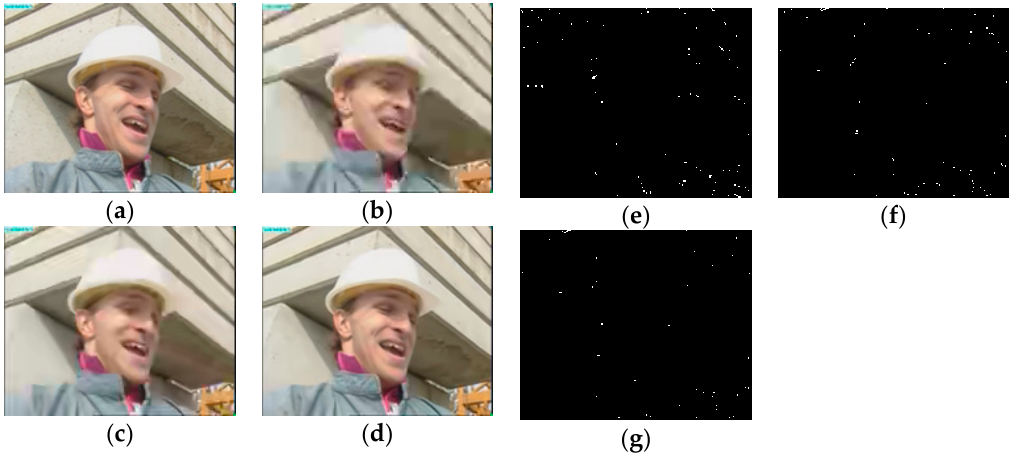
Figure 8. Evaluation of visual quality consistency for the 14 th decoded key frame of Foremen sequence obtained by ( a ) Original, ( b ) DISCOVER DVC, ( c ) H.265-DVC, and ( d ) proposed JEM-DVC. The bottom row shows the distortion images between the decoded key frames and the original frame, obtained by ( e ) DISCOVER DVC, ( f ) H.265-DVC, and ( g ) proposed JEM-DVC